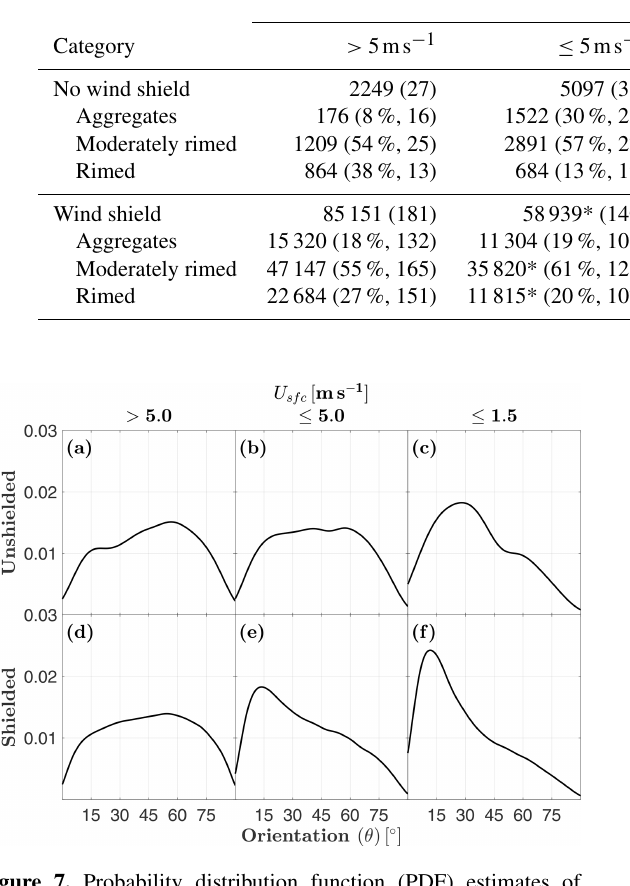
Figure 7. Probability distribution function (PDF) estimates of MASC-observed orientation angle θ as a function of surface wind speed U sfc for both shielded and unshielded configurations. Un- shielded and shielded MASC observations are from two separate periods: 29 November 2015–21 August 2016 and 22 August 2016– 28 August 2018, respectively.